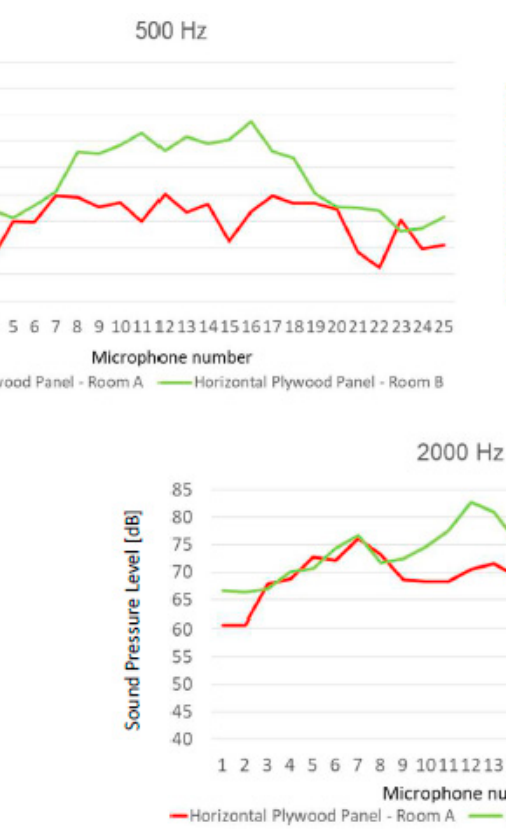
Figure 13. Comparison of the scattering coefficient based on measurements undertaken inside Room A and B.